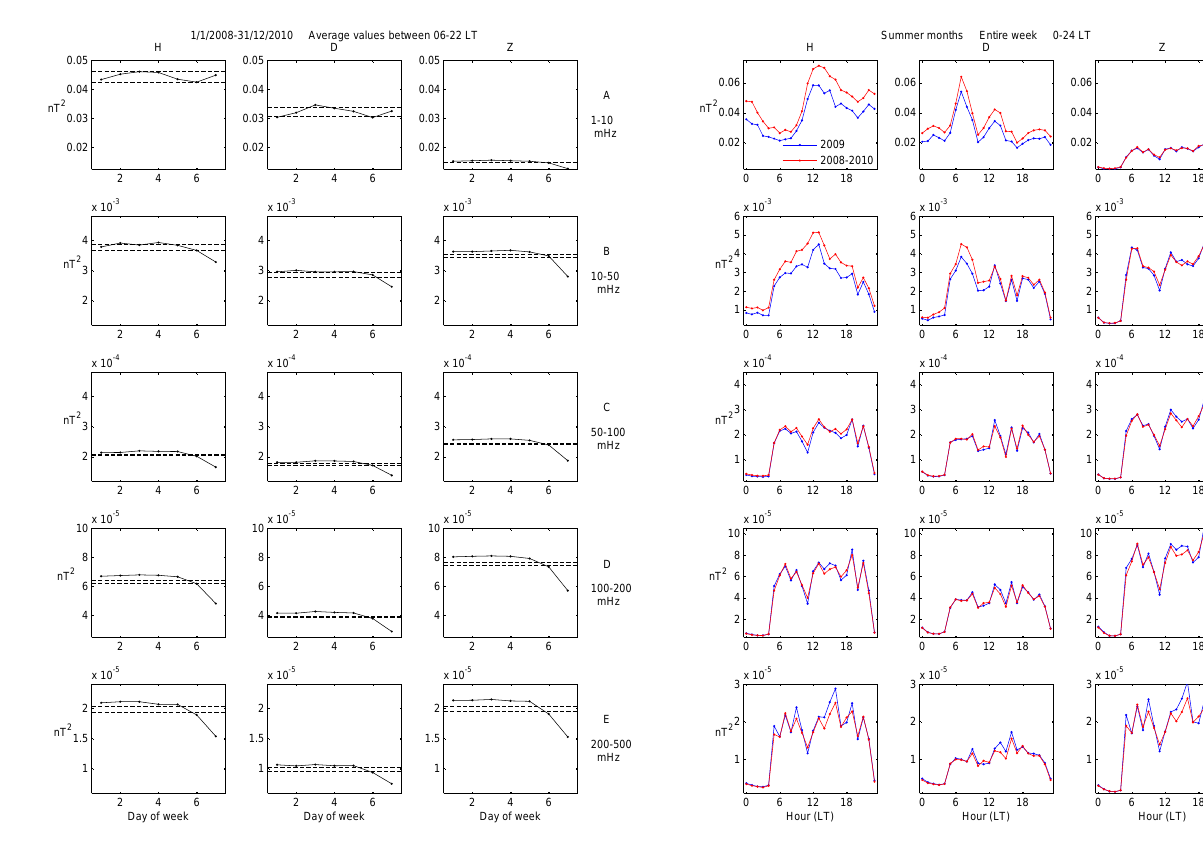
Figure 4. The daily average of the power levels in the dayside sec- tor as organized in terms of the weekdays (Monday = 1). The ratio between the ordinate limits for all panels is 4. Dashed lines identify the interval of 99% occurrence computed from randomly selected hourly powers.